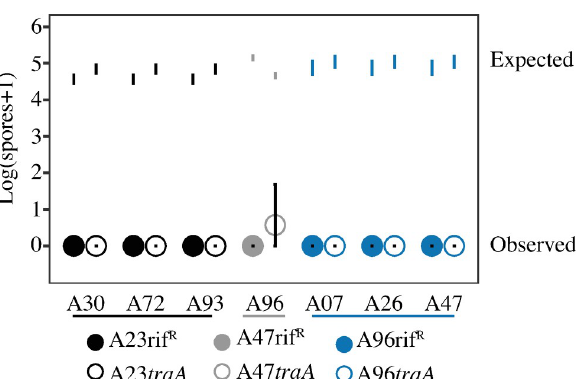
Fig 9. Severe antagonisms between TraA-identical natural isolates are independent of TraA. Antagonisms during development in which viable spore production by some natural isolates is eliminated (or nearly eliminated) in mixtures with other isolates are not alleviated by disruption of traA . Actual spore production by rifampicin-resistant variants of victim strains and respective kanamycin-resistant traA mutants in 1:99 initial mixtures with respective unmarked antagonizing isolates is represented by closed and open circles, respectively. Expected spore production of the victim strains from pure-culture assays is depicted by error bars with no circles. A23rif R and A23 traA (black circles) were each mixed with A30, A72 and A93, A47rif R and A47 traA (grey circles) were mixed with A96 and A96rif R and A96 traA (blue circles) were mixed with A07, A26 and A47. Error bars represent 95% confidence intervals, n = 3